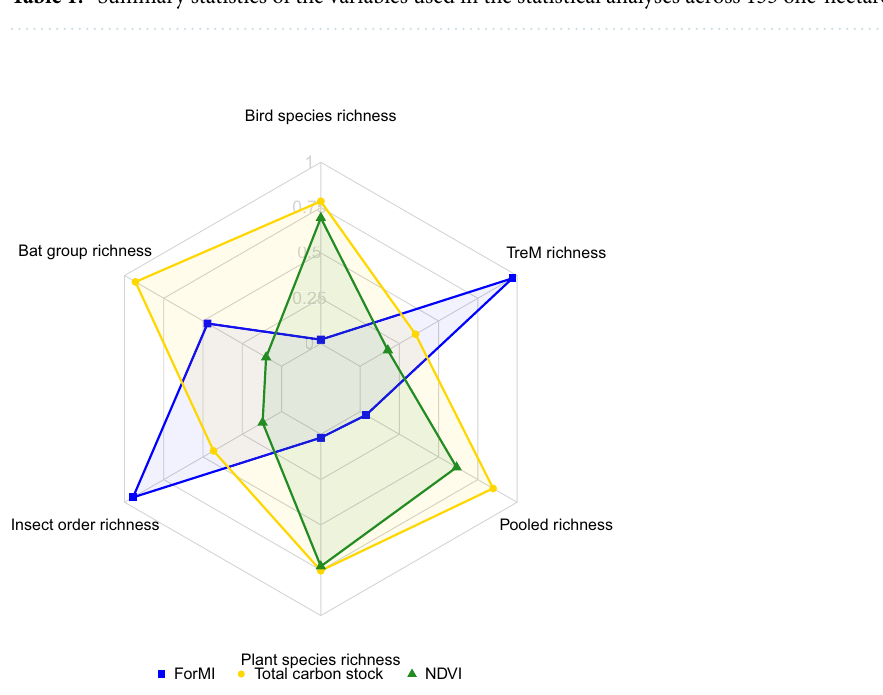
Table 1. Summary statistics of the variables used in the statistical analyses across 135 one-hectare forest plots.